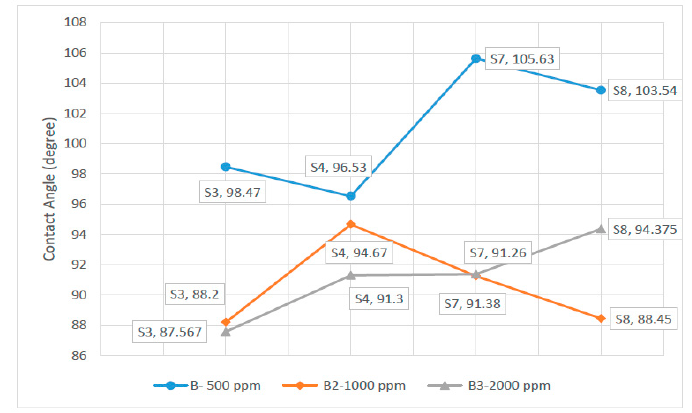
Figure 8. Variation in contact angle of samples containing montmorillonite clay with each brine.